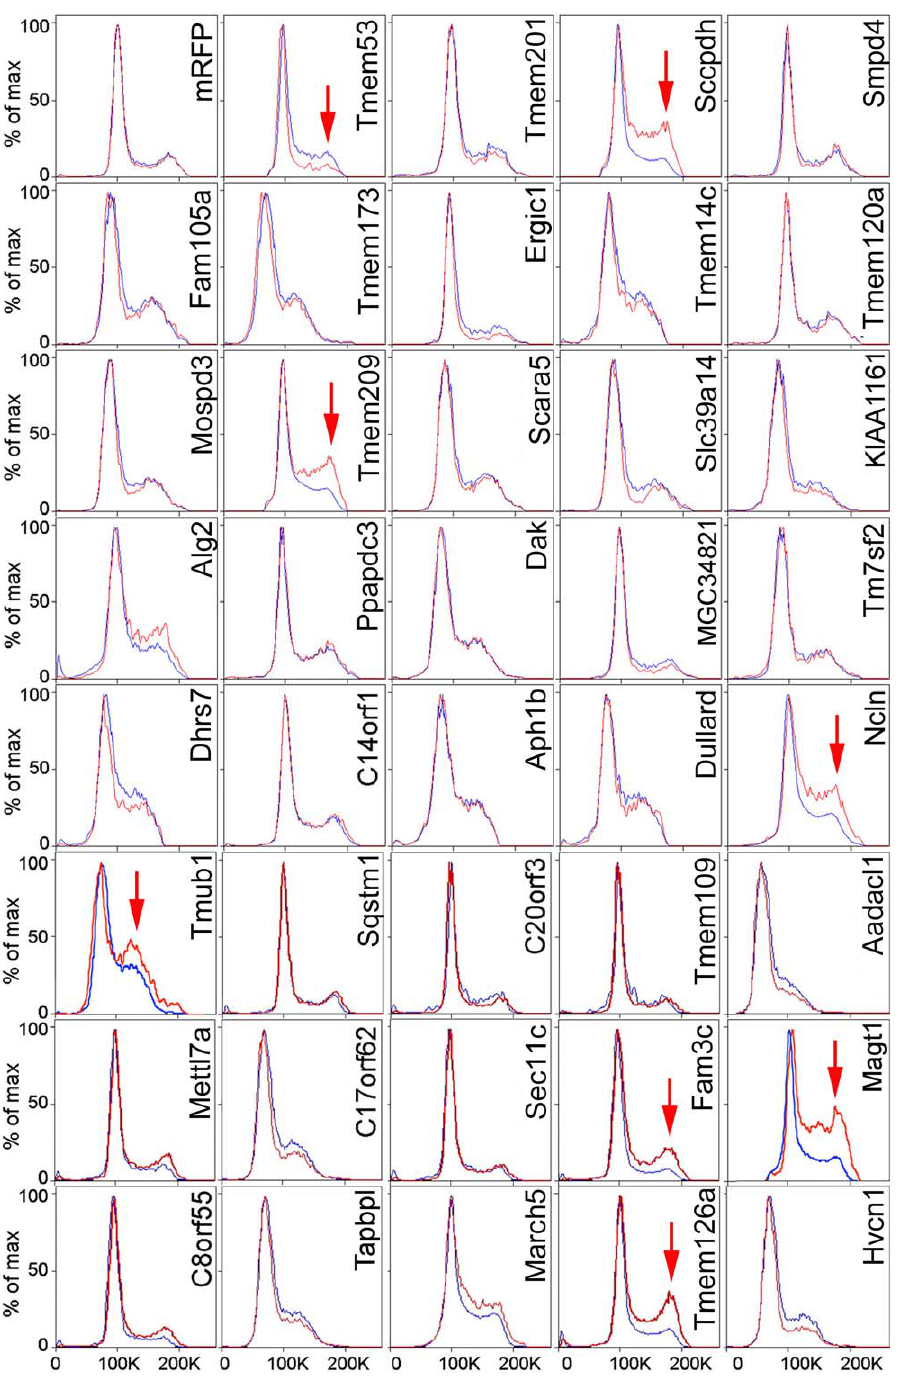
Figure 1. Changes in flow cytometry cell cycle profiles for cells overexpressing NETs. HEK293T cells expressing mRFP-NET fusions were recovered by trypsinization and analyzed by flow cytometry at 48 h post-transfection. Data were analyzed using FlowJo software and histogram overlays are displayed as %Max, scaling each curve to mode=100%. The red line is the mRFP expressing cells in the population while the blue line is the untransfected cells in the population (the majority of cells were not transfected). The transfected and untransfected populations were both set on the scale to 100 for the 2N population so that increases or decreases in the 4N peak reveal changes in the cell distribution. Arrows indicate significant changes in cell cycle profile between transfected and non-transfected cells. doi:10.1371/journal.pone.0018762.g001 blot. The p53, p38 and p21 antibodies used in subsequent assays from induction of stress pathways in some cells during transfection were tested by immunocytochemistry, but proved inadequate for (data not shown). Therefore, to further elucidate the pathways quantification due both to a diffuse distribution throughout the cell through which NET4/Tmem53 affects the cell cycle, its body and cell-to-cell variation in intensities that appears to result knockdown was attempted.